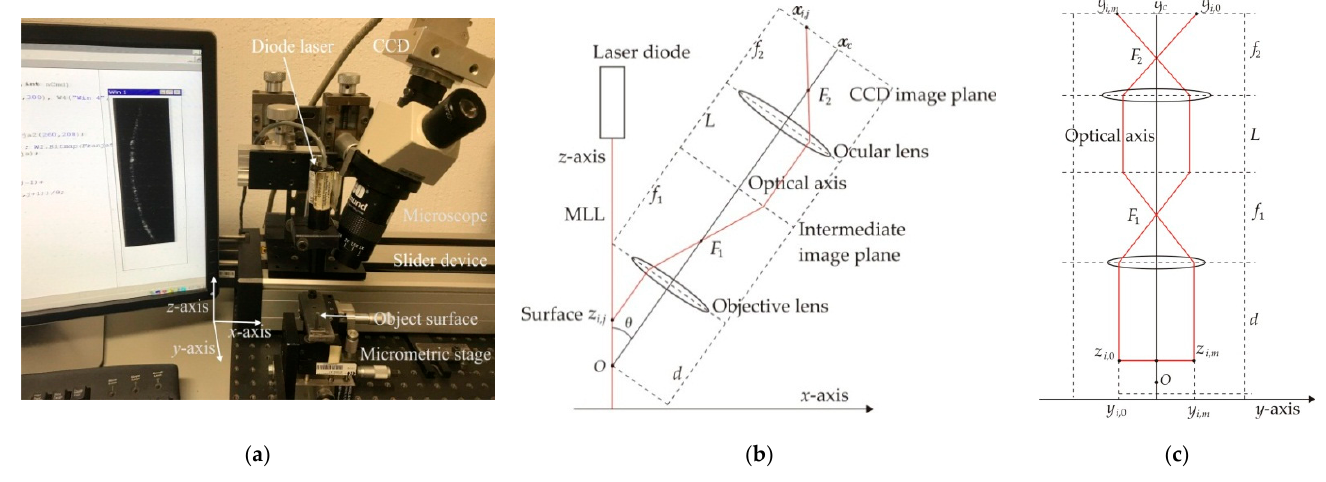
Figure 4. ( a ) Optical microscope vision system to perform micro-scale spherical and cylindrical surface modeling. ( b ) Lateral configuration of the microscope vision system in x -axis. ( c ) Lateral configuration of the microscope vision system in y -axis.